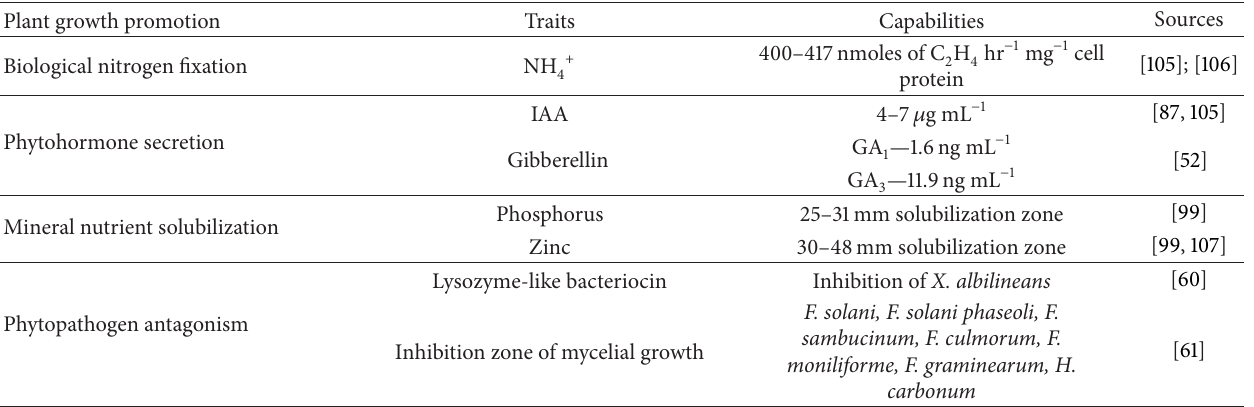
Table 4: Plant growth promoting properties of G.